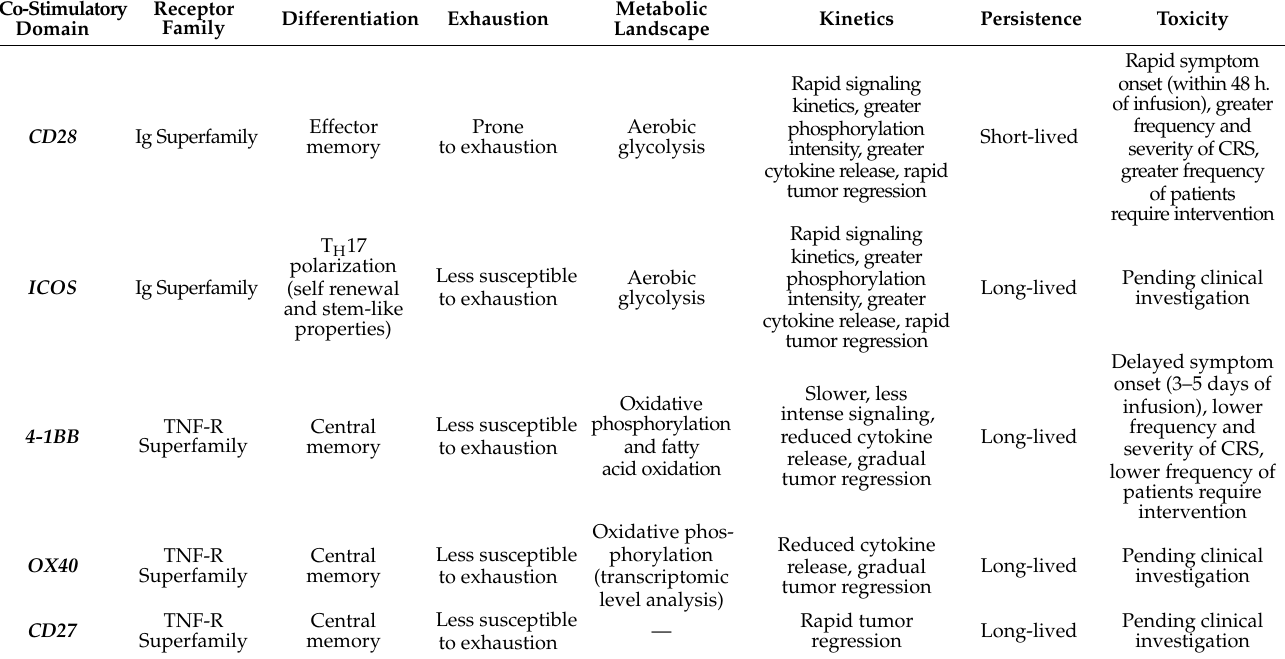
Table 1. Comparison of the functional attributes of co-stimulatory domains in second generation CAR-T